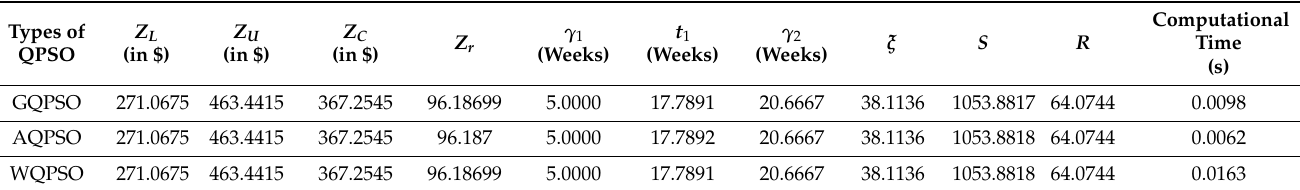
Table 6. Worst found results for Case-II of Example 2.